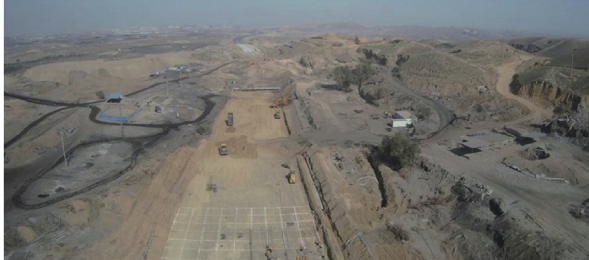
Figure 1: Panorama of construction site.